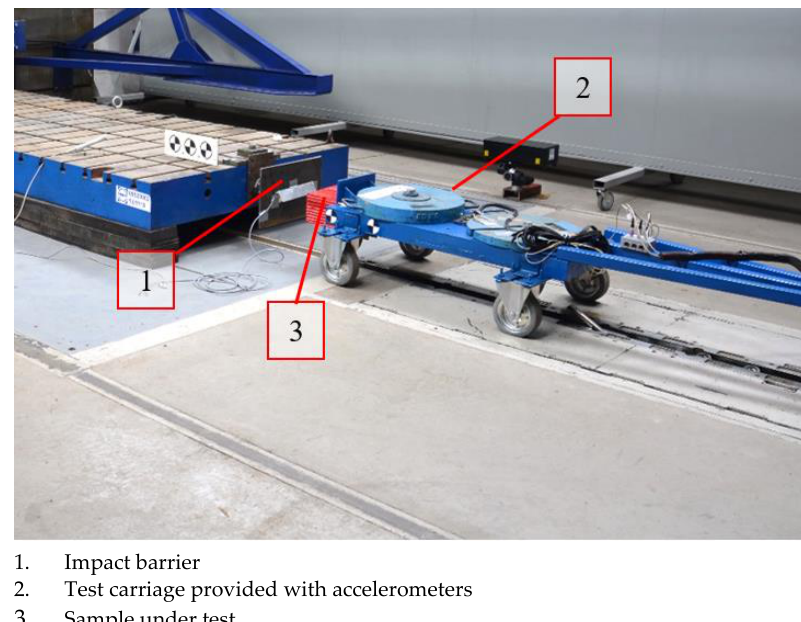
Figure 20. View of the dynamic test stand.